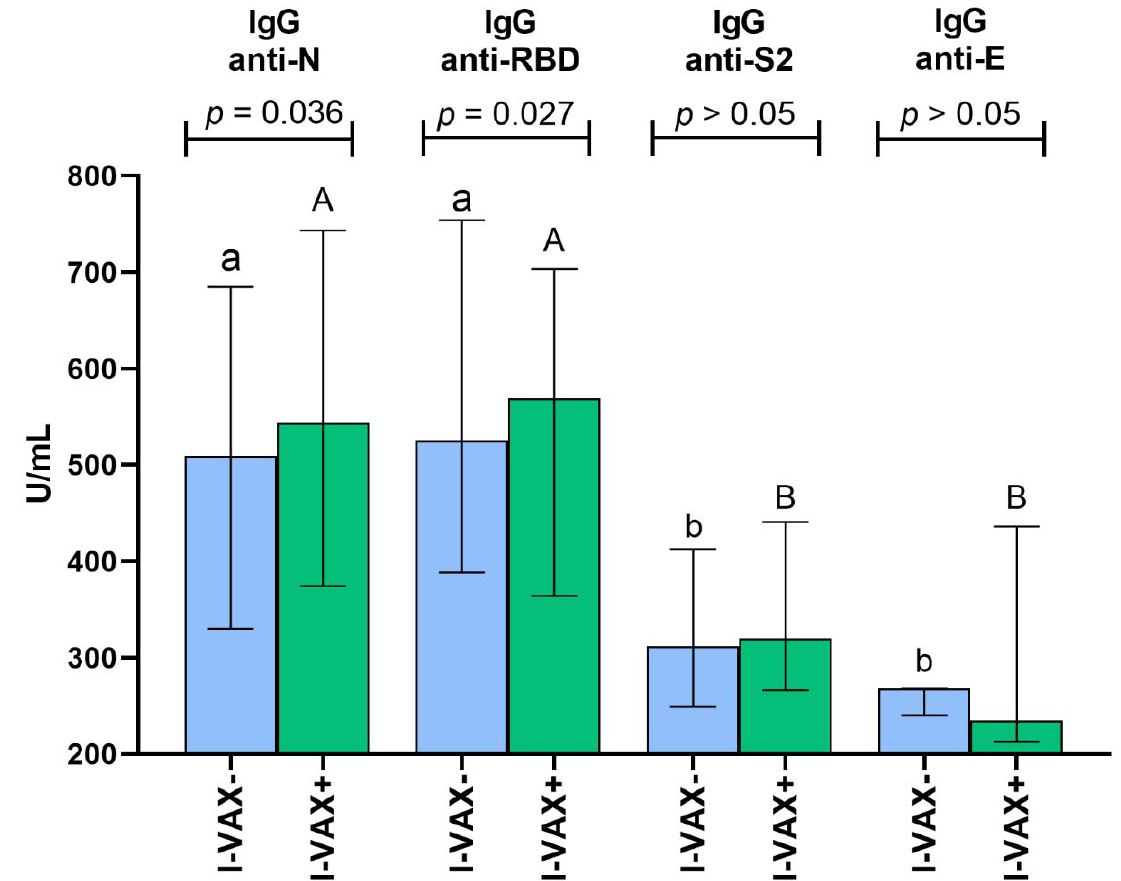
Figure 1. Serum titers (median and interquartile range) of IgG antibodies against SARS-CoV-2 nucleocapsid protein (anti-N), receptor binding domain of spike protein (anti-RBD), subunit S2 of spike protein (anti-S2), and envelope protein (anti-E) in mild COVID-19 convalescent individuals not vaccinated (I-VAX-) and vaccinated (I-VAX+) against seasonal influenza. The p -value refers to the difference between these groups examined with the Mann–Whitney U test. Different small letters (a, b) above bars indicate a significant difference between antibody concentrations within the I-VAX- group, while different capital letters (A, B) indicate it within the I-VAX+ group (Kruskal–Wallis ANOVA with Dunn’s post hoc